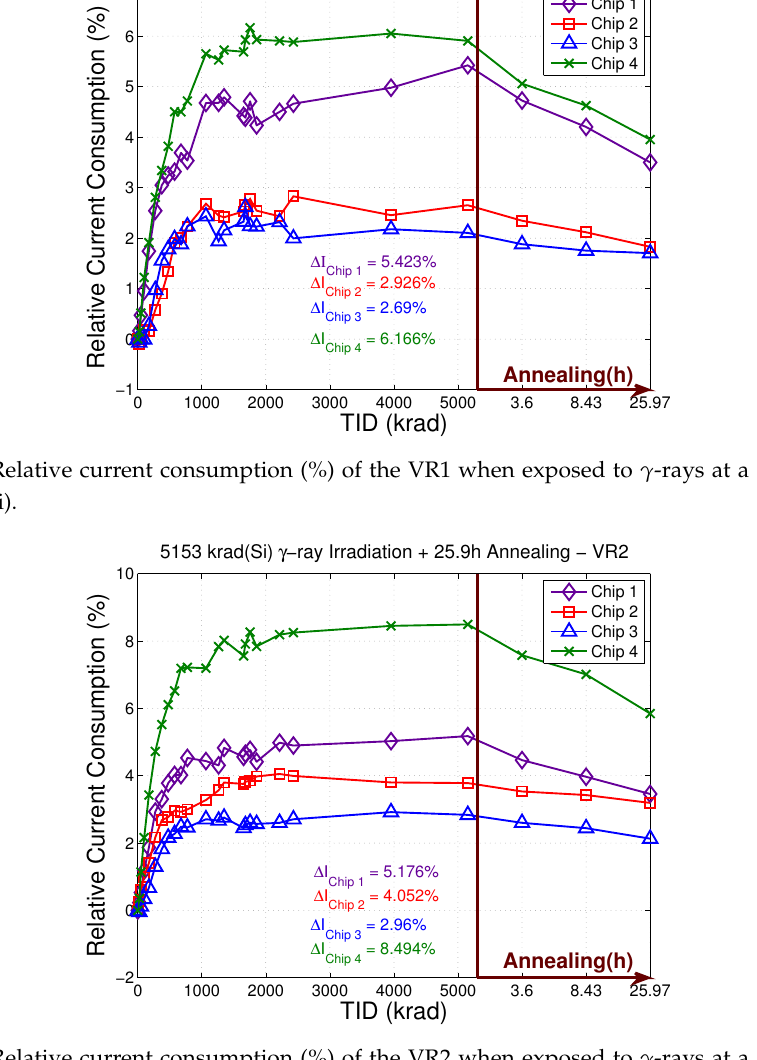
Figure 15. Relative current consumption (%) of the VR2 when exposed to γ -rays at a dose rate of 25